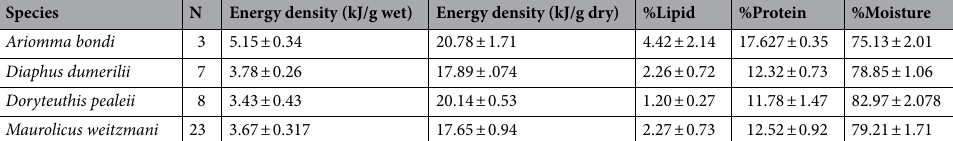
Table 3. Energy density and proximate composition of Rice’s whale ( Balaenoptera ricei ) prey from the Gulf of Mexico.